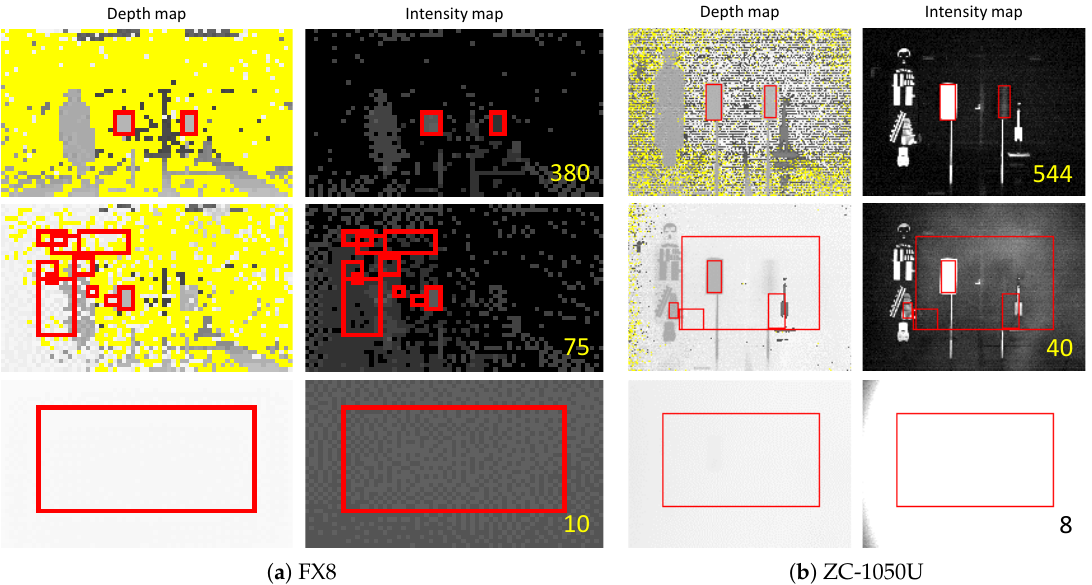
Figure 14. Experiment results by the emulated Electro-Sensitive Protective Equipment (ESPE)